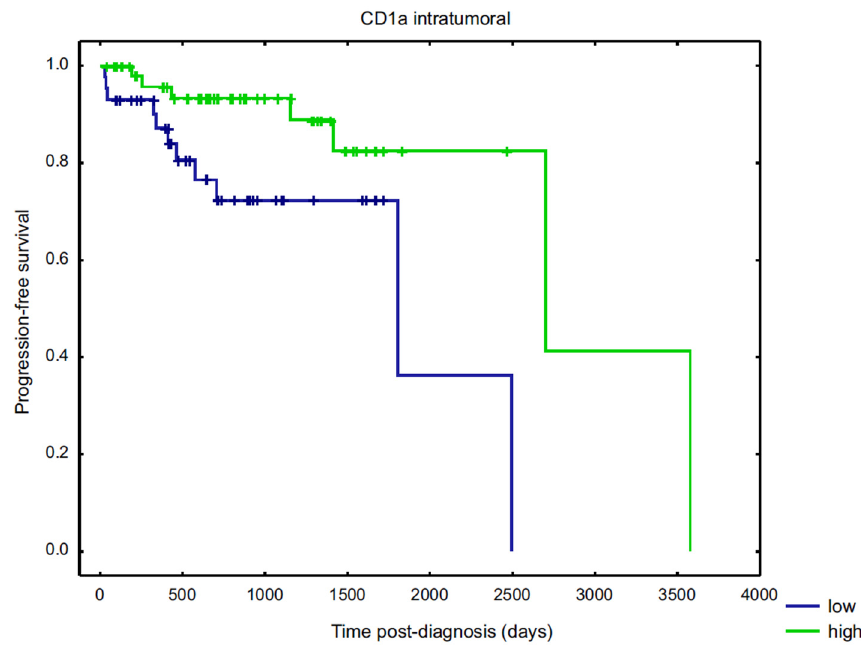
Figure 4. Kaplan–Meier curves for progression-free survival (PFS). Comparison of PFS according to intratumoural CD1a+ cell infiltration stratified by the median value of positively stained cells.